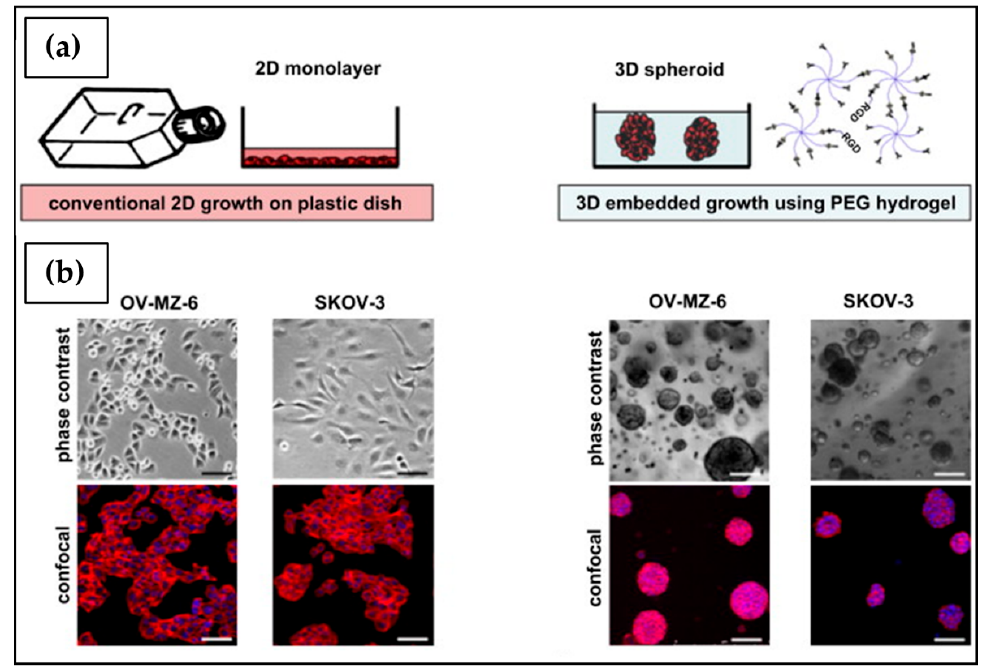
Figure 16. PEG-based hydrogel. ( a ) Schematic illustration of OC cells grown in a monolayer on traditional plastic surfaces (left) and in 3D as spheroids embedded within hydrogels (right). ( b ) OV-MZ-6 and SKOV-3 cells formed in 2D typical monolayers (left) and 3D systems (right), shown by phase contrast (top panel) and confocal (bottom panel; cell actin filaments stained with rhodamine phalloidin, nuclei with DAPI) microscopy images (scale bars, 75 μ m) [208].